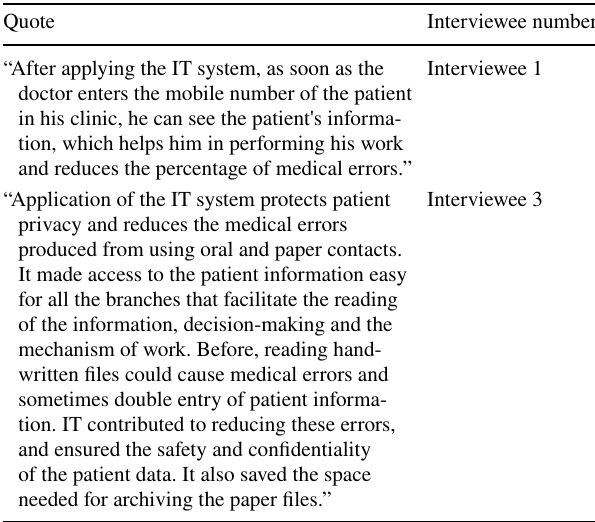
Table 2 Positive effects of IT on healthcare through ease of access